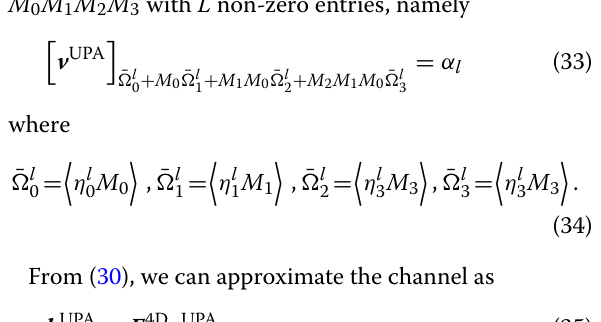
2 In general, the number of symbols can be larges